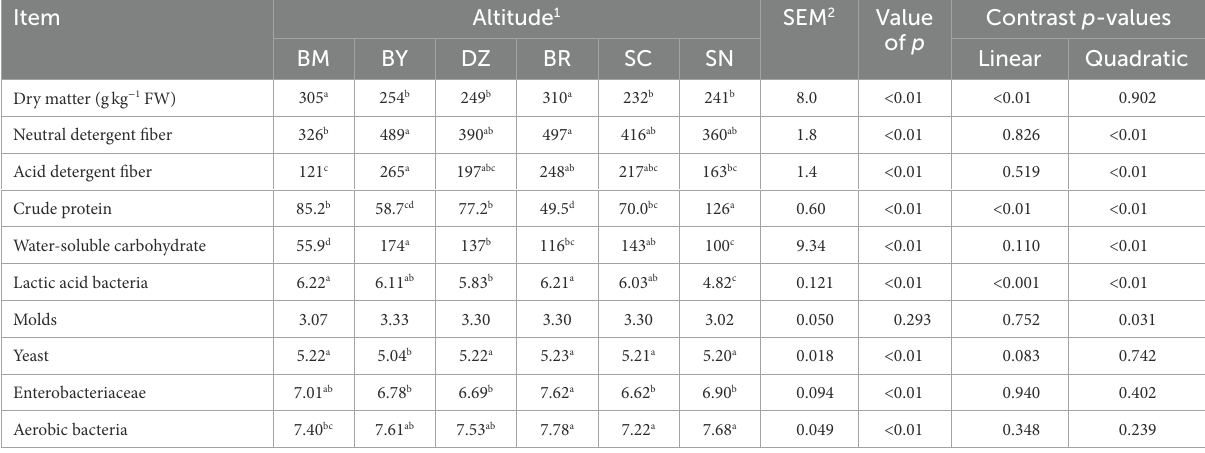
TABLE 1 The chemical composition (g/kg DM basis unless stated otherwise) and microbial populations (log 10 cfu/g FW) of fresh oat ( Avena sativa L.). Item